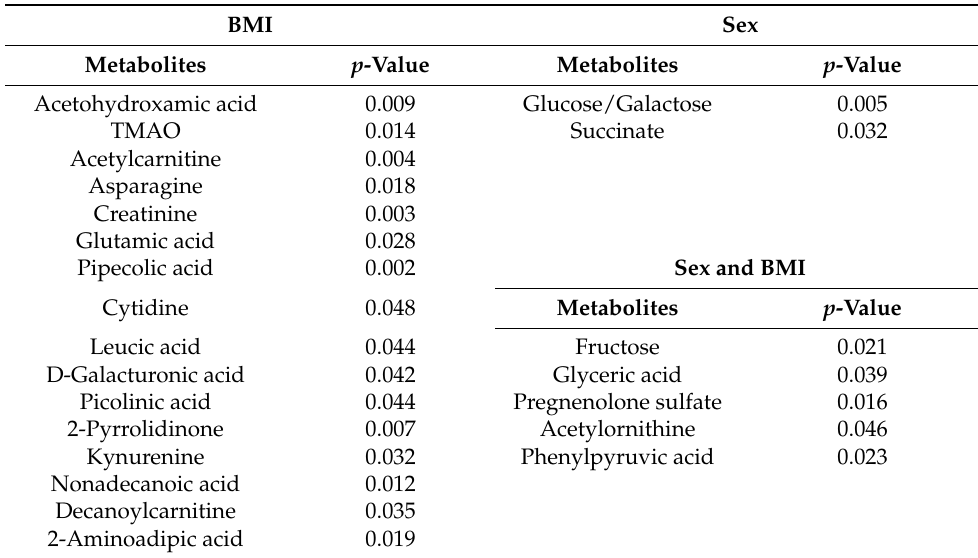
Table 4. Two-way ANOVA assessing sex, BMI, and the